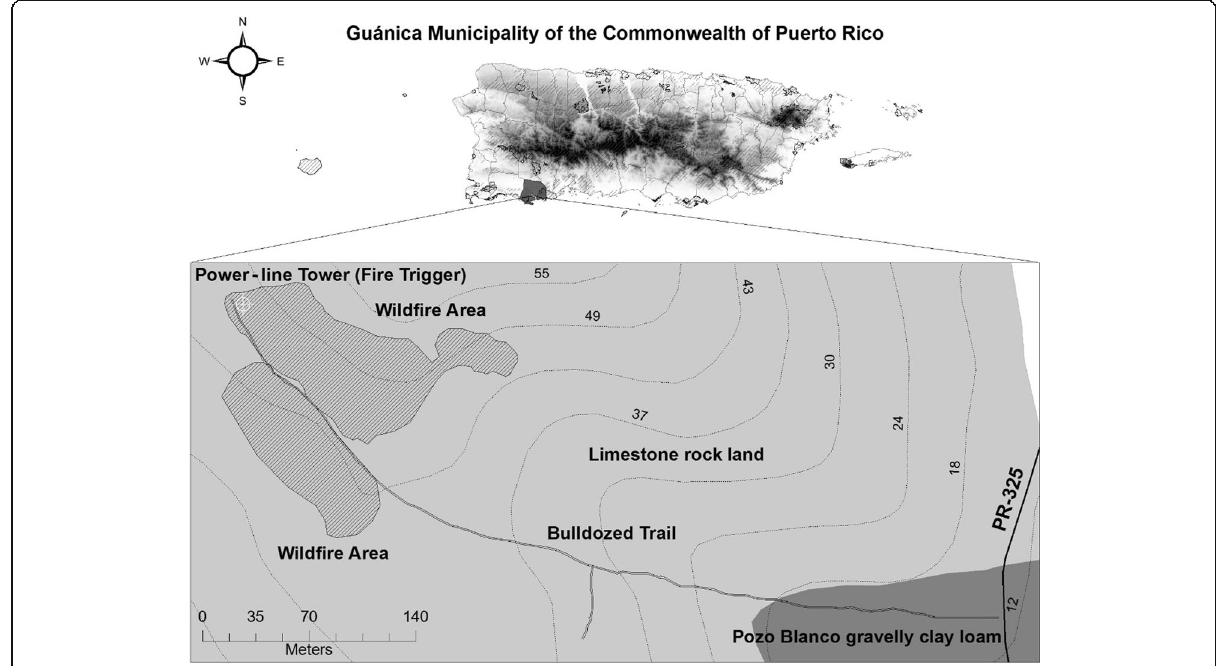
Fig. 1 Map of the 570-m long bulldozer trail from road PR-325 (at right) to the power-line tower that was the fire source (shaded area near top left). Elevation on contours in meters. Fire occurred in mature, native-dominated forest in the Ensenada sector of Guánica Forest, PR. Transect point 0 is at the intersection of the trail and PR